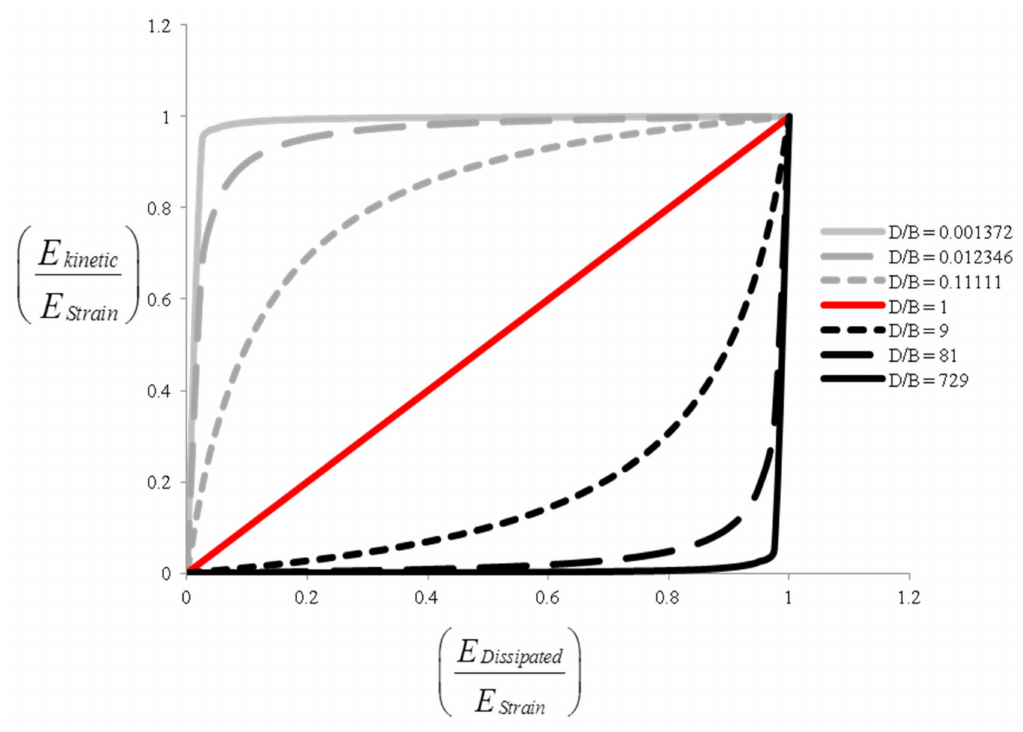
Figure 4. The interaction between the di ff erent types of energy due to the e ff ect of the damage in a coal mass and strata layers ( D / B = 3 n ).